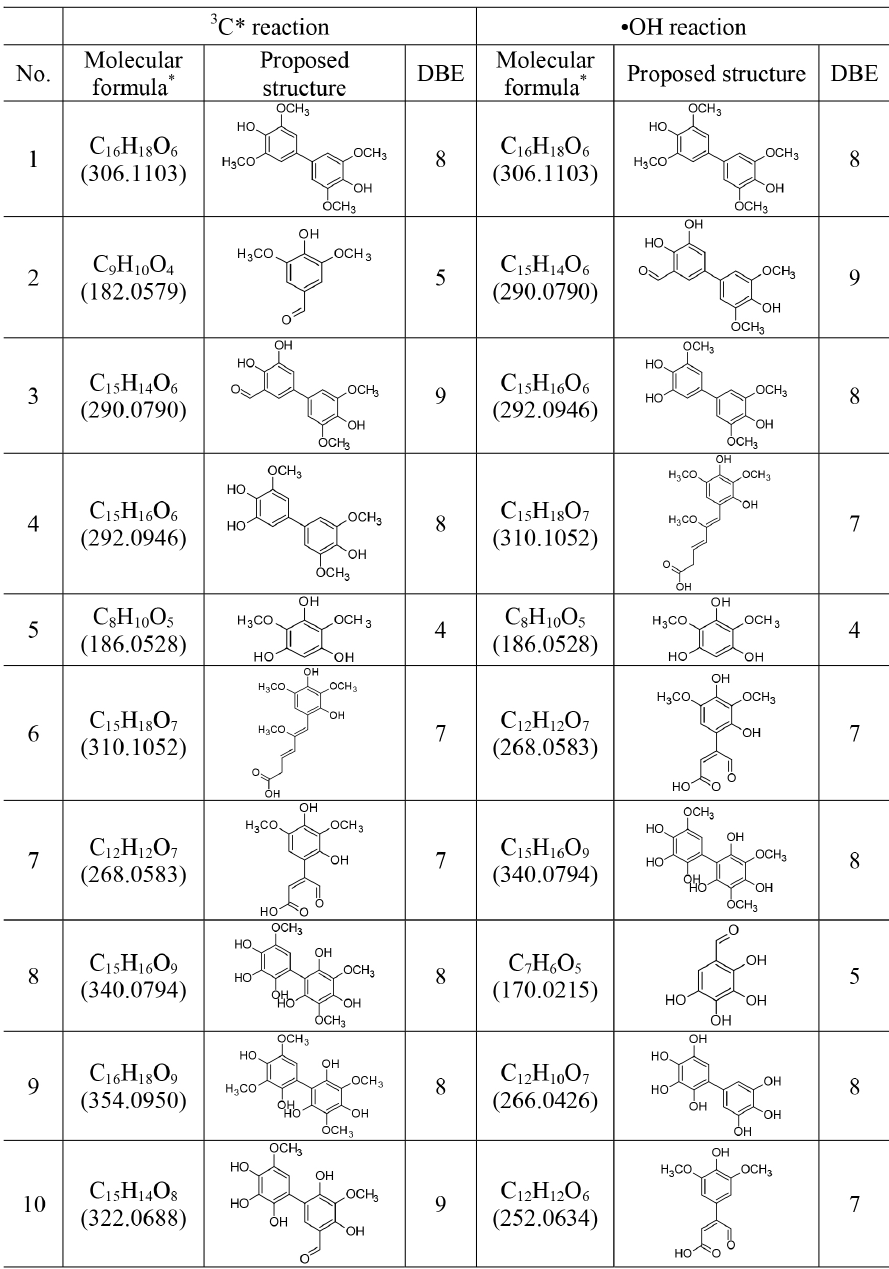
Table 2. Top 10 most abundant compounds in syringol SOA formed in 3 C ∗ -mediated and · OH-mediated reactions identified with ( − ) nano-DESI